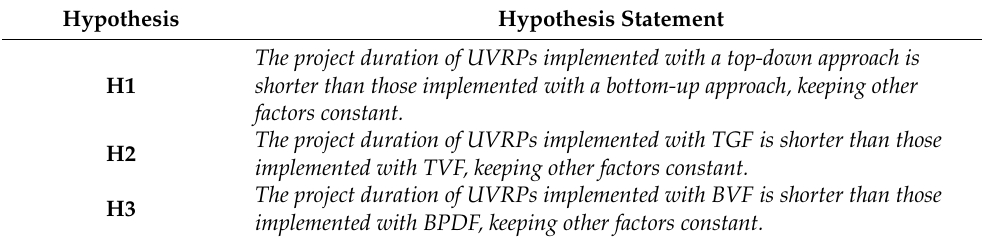
Table 1. Hypotheses for empirical